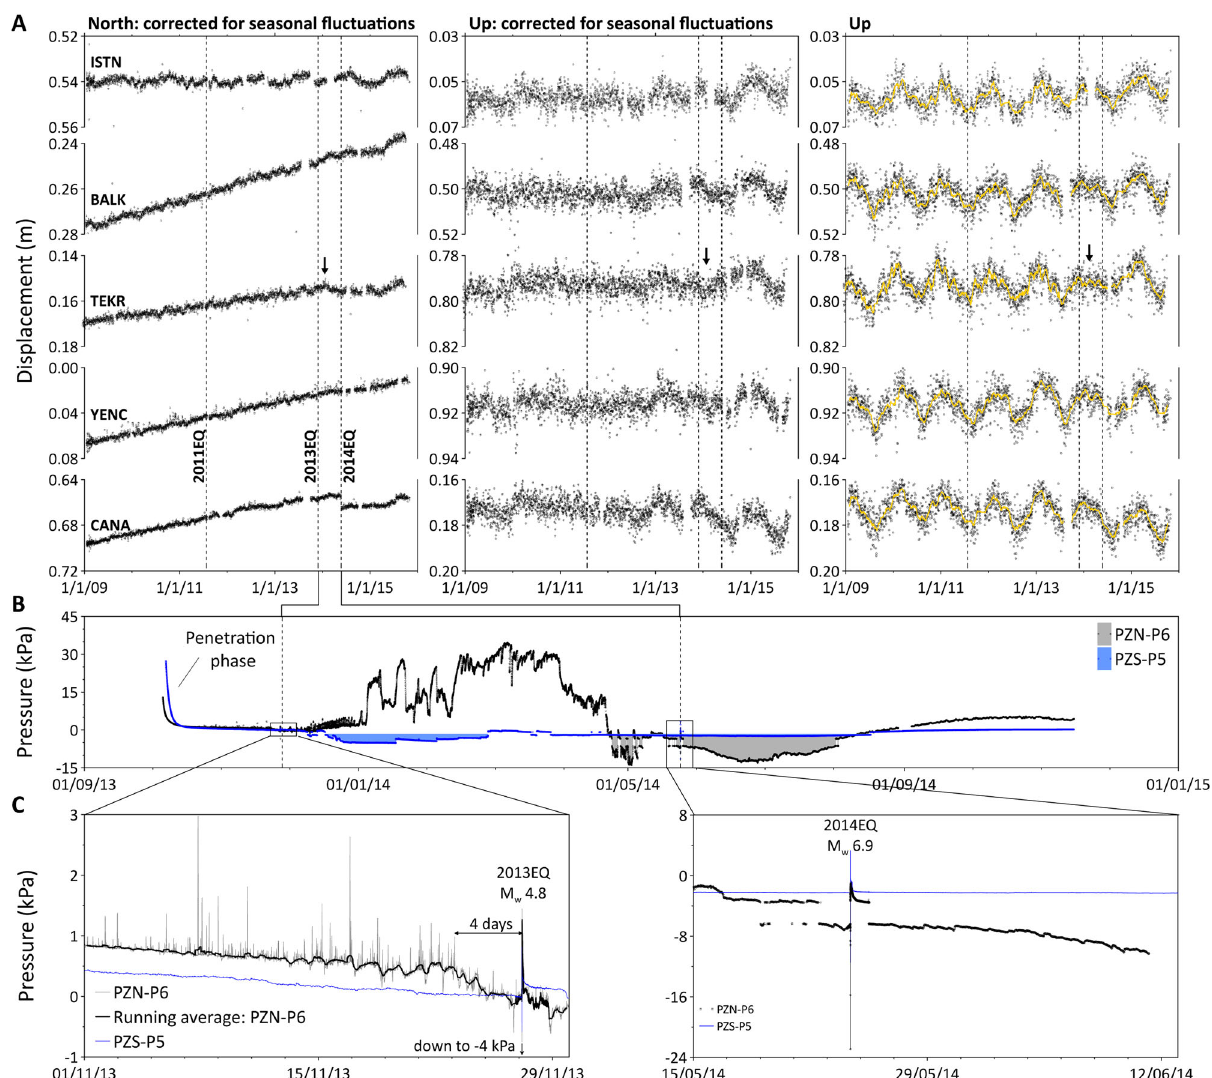
Fig. 3 Time series data. A Displacement time series (from left to right: north and up components corrected for seasonal fl uctuations and non-corrected up component) for fi ve sites surrounding the Sea of Marmara. From west to east: CANA, YENC, TEKR, BALK, and ISTN stations (locations in Fig. 1A). The three vertical dashed lines indicate the timing of three neighboring earthquakes (25 July 2011 — 2011EQ, 2013EQ, and 2014EQ). The range of the vertical axes is adjusted to better visualize the majority of the data. Arrows indicate perturbations that occur between 2013EQ and 2014EQ. B Pore-pressure time series measured at depths below the seabed of 7.08 m (PZN-P6) and 6.28 m (PZS-P5). C Enlargement diagrams showing the pore-pressure evolutions during 2013EQ and 2014EQ. The horizontal scale uses the convention of day, month, and